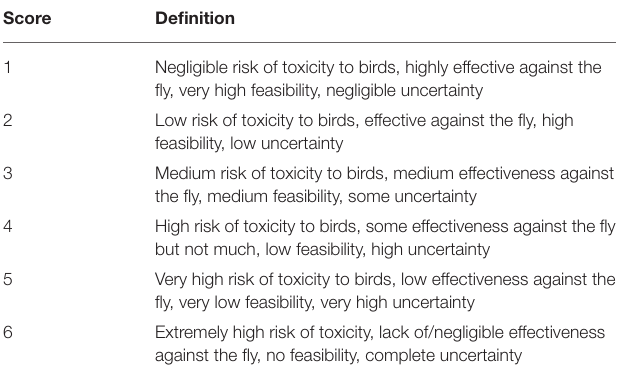
TABLE 1 | Definitions for the scores (1–6) used in the risk assessment